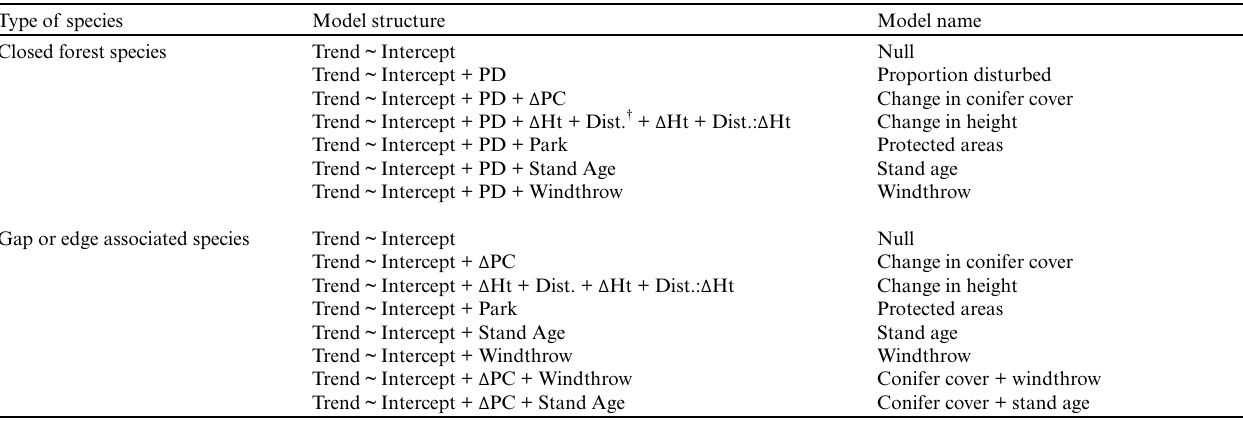
Table 4. A priori candidate models examining variation in stand-level trends in forest bird abundance between circa 1994 and 2014. PD = proportional change in original stand area, Δ PC = change in proportion of canopy composed of coniferous trees, Dist. = disturbance, Δ Ht = change in stand